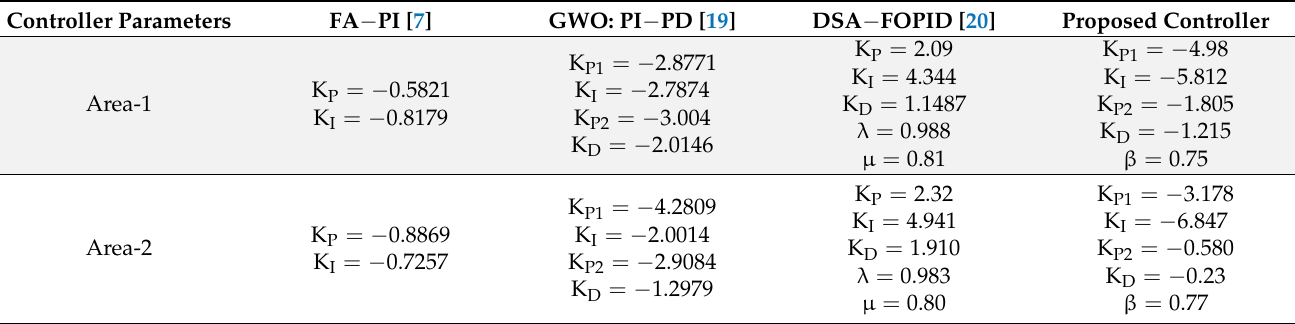
Table 2. C ontrollers’ parameters after 100 iterations.